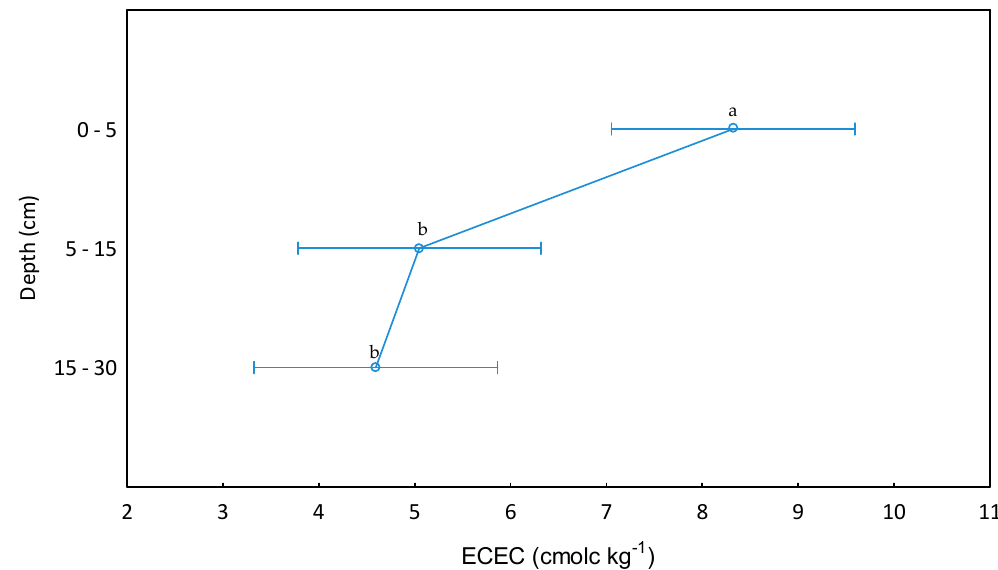
Figure 3. ECEC between 0–5, 5–15, and 15–30 cm soil depths of soils where at least one depth increment had pH (KCl) ≤ 5.0. ECEC = Effective cation exchange capacity. No common superscript letter indicates a significant ( p ≤ 0.05) difference.